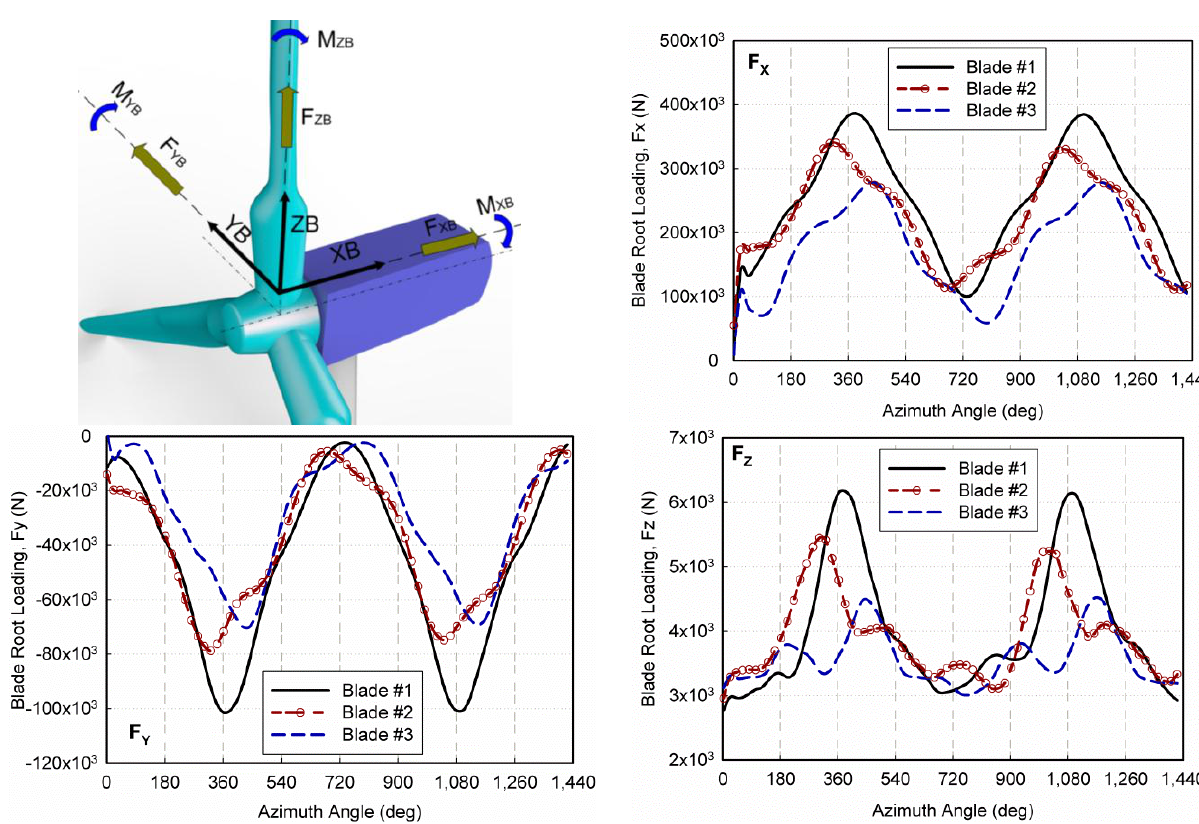
Figure 11. Unsteady aerodynamic load on the blade coordinate system by the CFD–RBM approach (Amp = 4°, Freq = 0.1